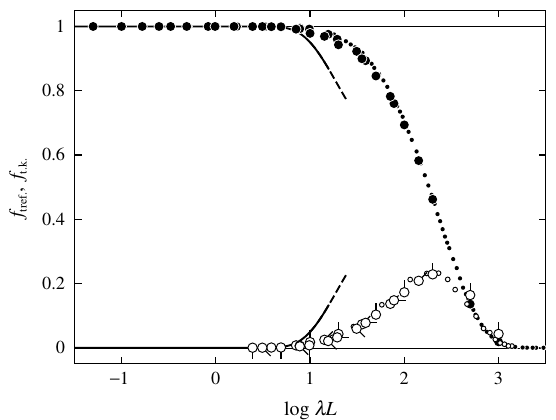
Figure 1. Plots of f tref. and f t.k. against log λ L . The large open circles represent the Monte Carlo (MC) values of f tref. for the discrete Kratky–Porod (KP) ring with βα = 0 (pip up); 0.3 (pip right-up); 1 (pip right); 3 (pip right-down); and 10 (pip down). The small open circles represent the MC values of f tref. for the Gaussian ring obtained by Tsurusaki and Deguchi [16]. The large and small closed circles represent the MC values of f t.k. for the discrete KP ring obtained in the previous study [7] and those for the freely jointed ring obtained by Moore et al. [20], respectively. The lower and upper curves represent the theoretical values for f tref. and f t.k. , respectively, calculated on the assumption that the mixed ensemble includes only the most-probable configurations of the trefoil and trivial knots (see text).